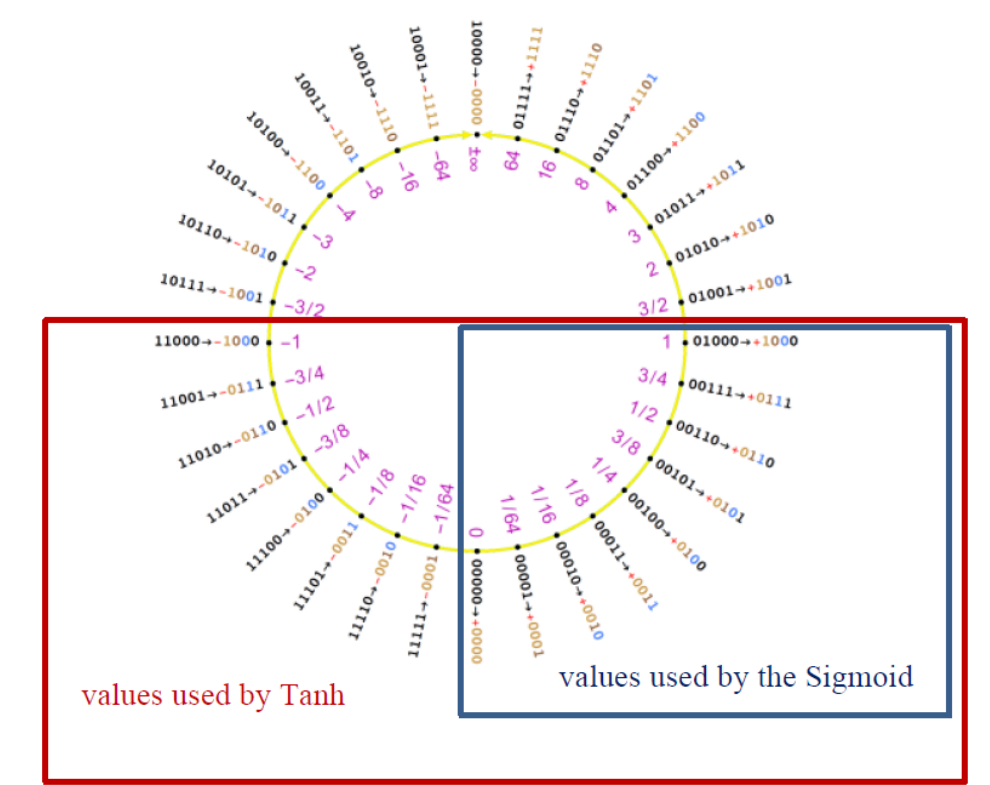
Figure 6. Five-bit Posit mapping to the Posit circle: As reported, the tanh function manages to cover the lower half of the circle while the sigmoid one covers only the quarter [ 0,1 ]